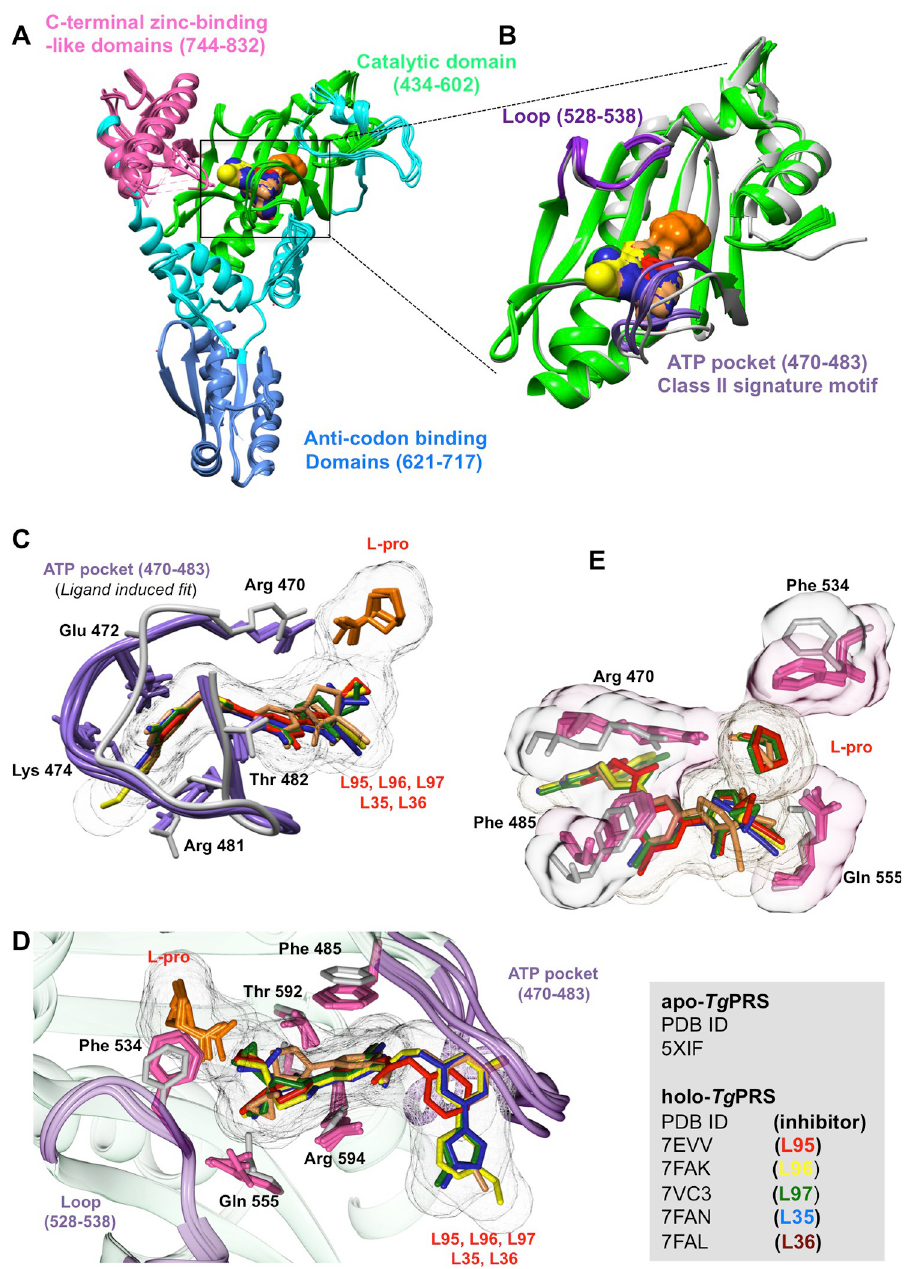
Fig 7. The five inhibitors in complex with Tg PRS. Overall structures of L95-, L96-, L97-, L35-, and L36-bound Tg PRSs. (A) Tg PRS-holo can be divided into three domains. The catalytic domain (434–602), anti-codon binding domain (621–717) and C-terminal zinc-binding-like domain (744–832). (B) The ATP pocket (470–483) class II signature motif and the loop (528–538) are shown in purple. (C) Structural comparison of the Tg PRS-apo (in grey) and the ATP-mimetics-bound Tg PRS-holo (in purple) is shown. (D and E) The residues forming the cavity compound and the L-pro cavity are